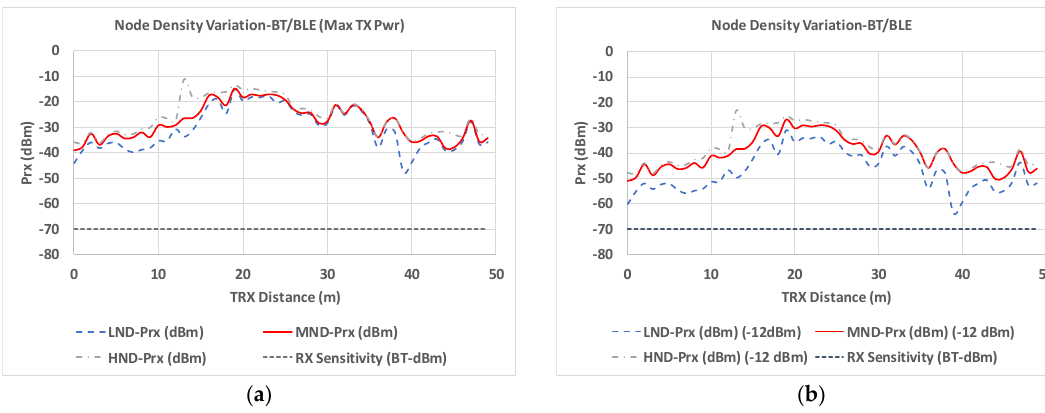
Figure 14. Coverage/capacity estimation for BT/BLE transceiver operation ( a ) max transmission Figure 14. Coverage / capacity estimation for BT / BLE transceiver operation ( a ) max transmission power power (4 dBm) ( b ) conventional transmission power ( − 12dBm). (4 dBm) ( b ) conventional transmission power ( −